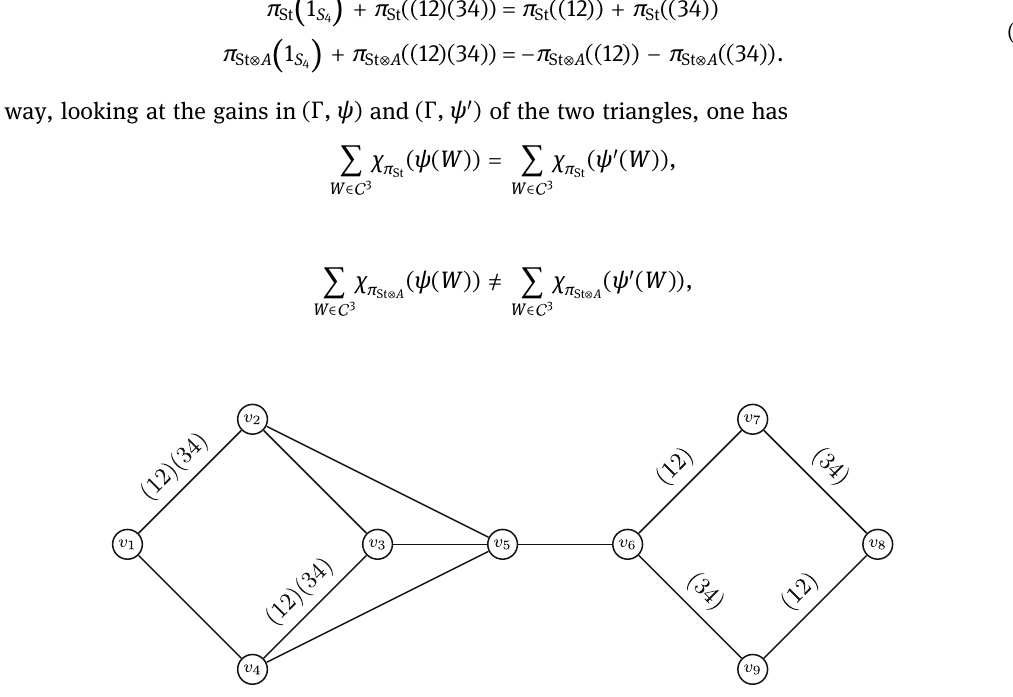
Figure 4: The S 4 - gain graph ψ Γ, ( ) of Example